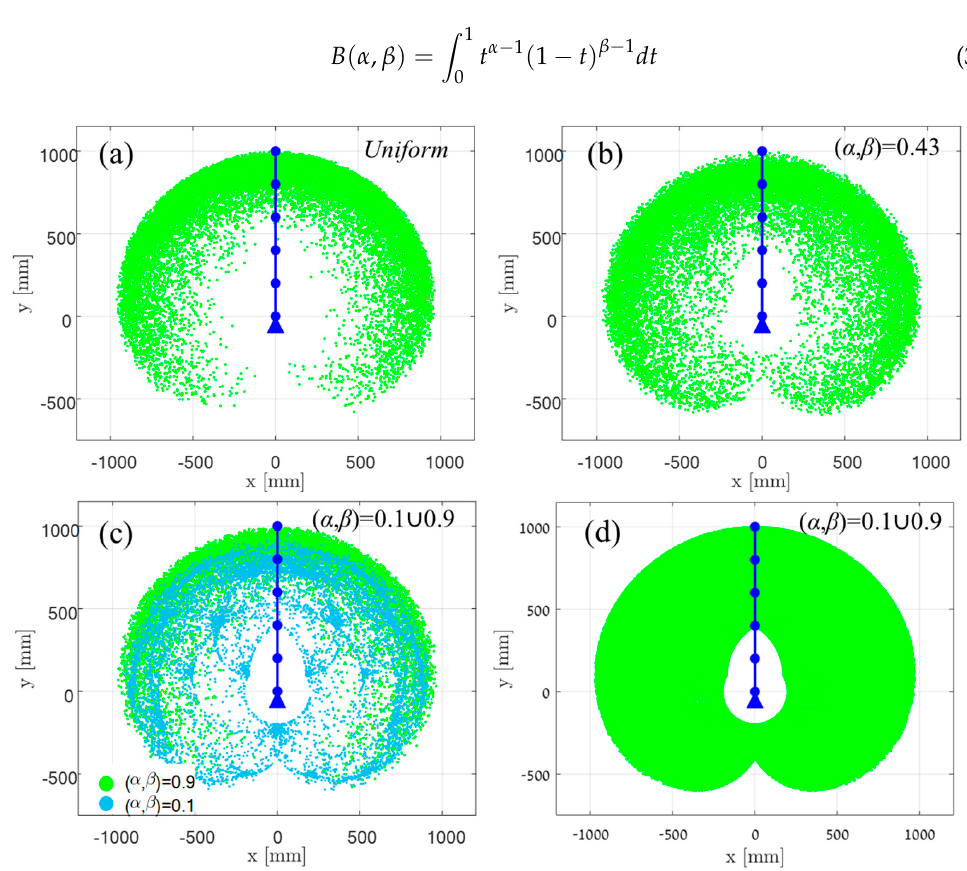
Figure 3. Workspace computation of the 5R manipulator, with a uniform link length of 200 mm and a relative joint angle range θ j ∈ [ − 60°,60°], using 20,000 Monte Carlo points with uniform and beta distribution functions. ( a ) Generating a workspace cloud with uniformly distributed points (green); ( b ) Using a beta distribution with ( α , β ) = 0.43; ( c ) and ( d ) combining the two regions produced with ( α , β ) = 0.1 (blue) and ( α , β ) = 0.9 (green) for 20,000 and 1,000,000 points, respectively.